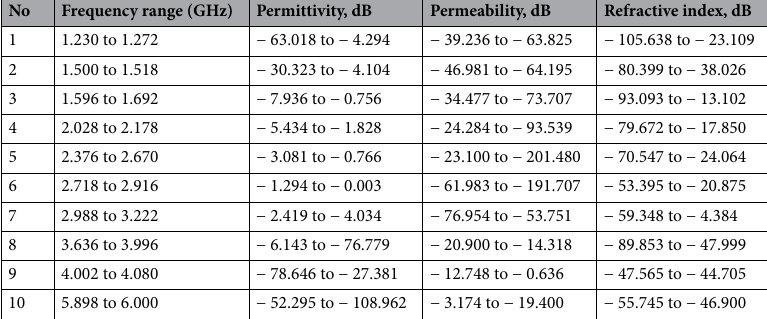
Table 3. Frequency ranges of left-handed characteristics for all resonance